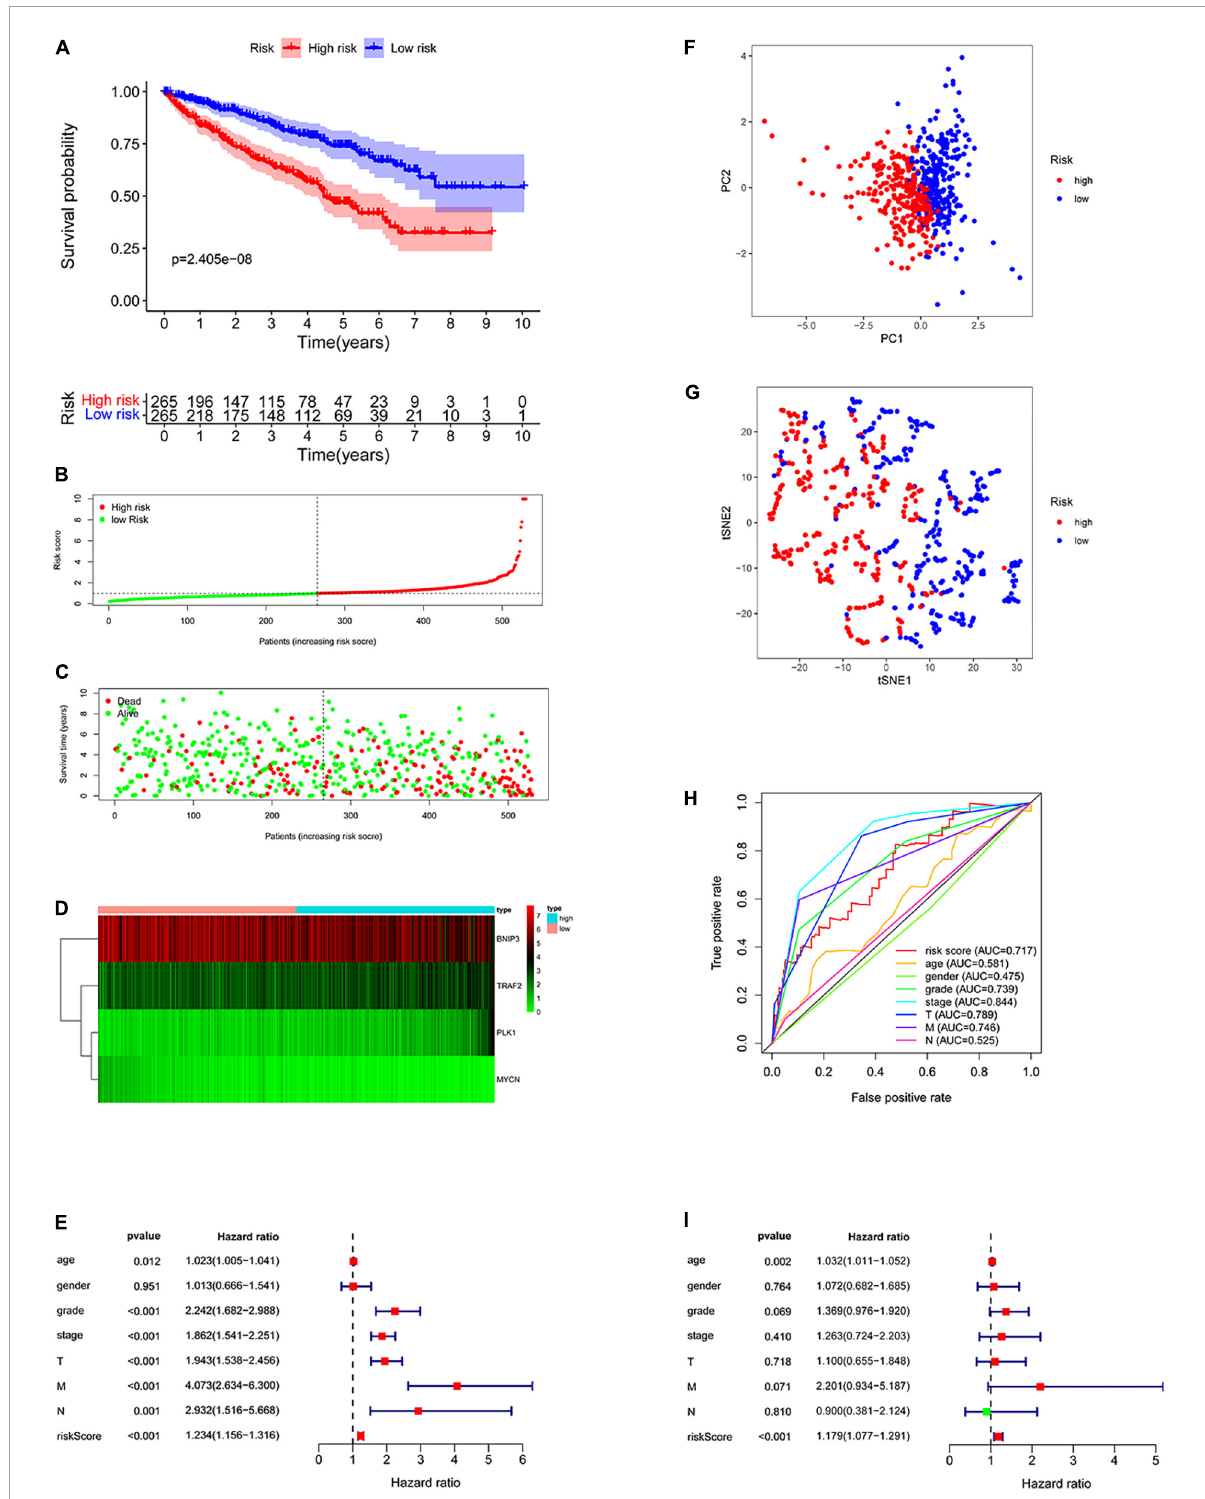
FIGURE5 Construction of the prognostic prediction model. (A) The Kaplan–Meier survival curve of low-risk groups; (B) prognostic model distribution of patients with ccRCC; (C) the survival status of patients in the low- and high-risk groups; (D) the expression of the four NRGs; (E) univariate Cox regression analysis; (F) principal component analysis (PCA) plot of the prognosis model; (G) t -distributed stochastic neighbor embedding (t-SNE) analysis of the prognosis model; (H) receiver operating characteristic (ROC) curve showing the predictive precision of the prognosis model; (I) multivariate Cox regression